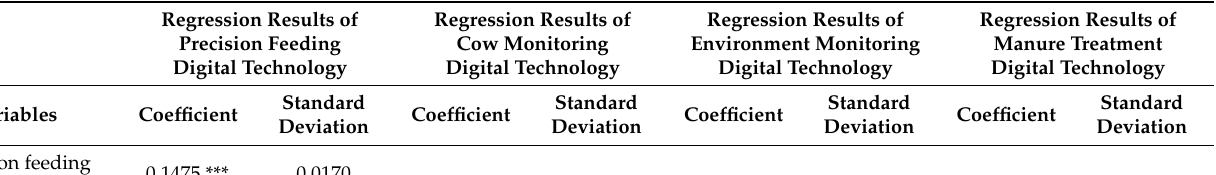
Table 5. The regression results of heterogeneous numerical technique application on carbon emission efficiency in dairy